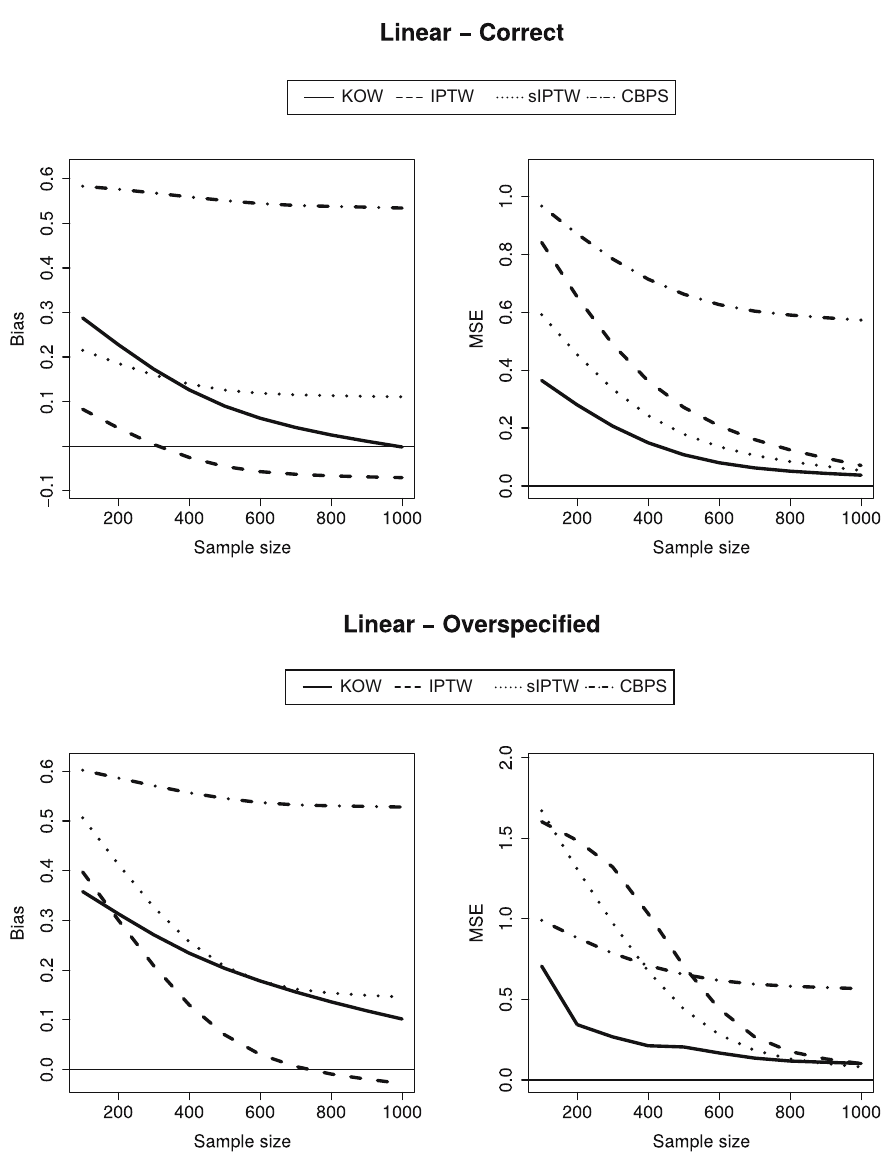
Figure 1: Bias and MSE of the estimated time - varying treatment e ff ect using KOW ( solid ) , IPTW ( dashed ) , sIPTW ( dotted ) , and CBPS ( dashed - dotted ) when increasing the sample size from n 100 = to n 1,000 = in the linear - correct scenario ( top panels ) and in the linear - overspeci fi ed scenario ( bottom panels )